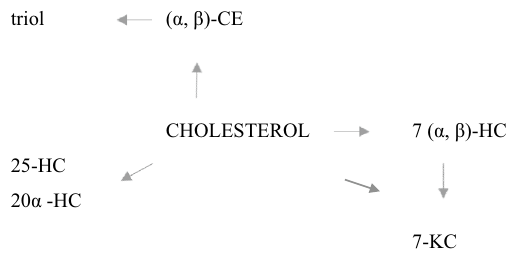
Figure 1. Simplified scheme of oxysterols formation.